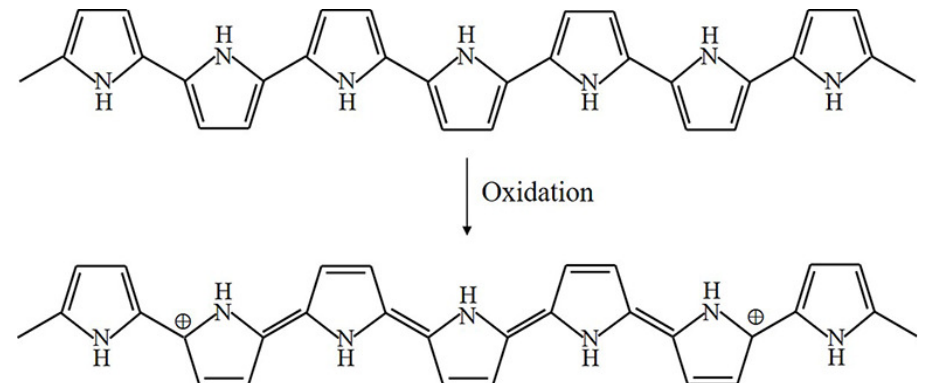
Figure 3. Oxidation of